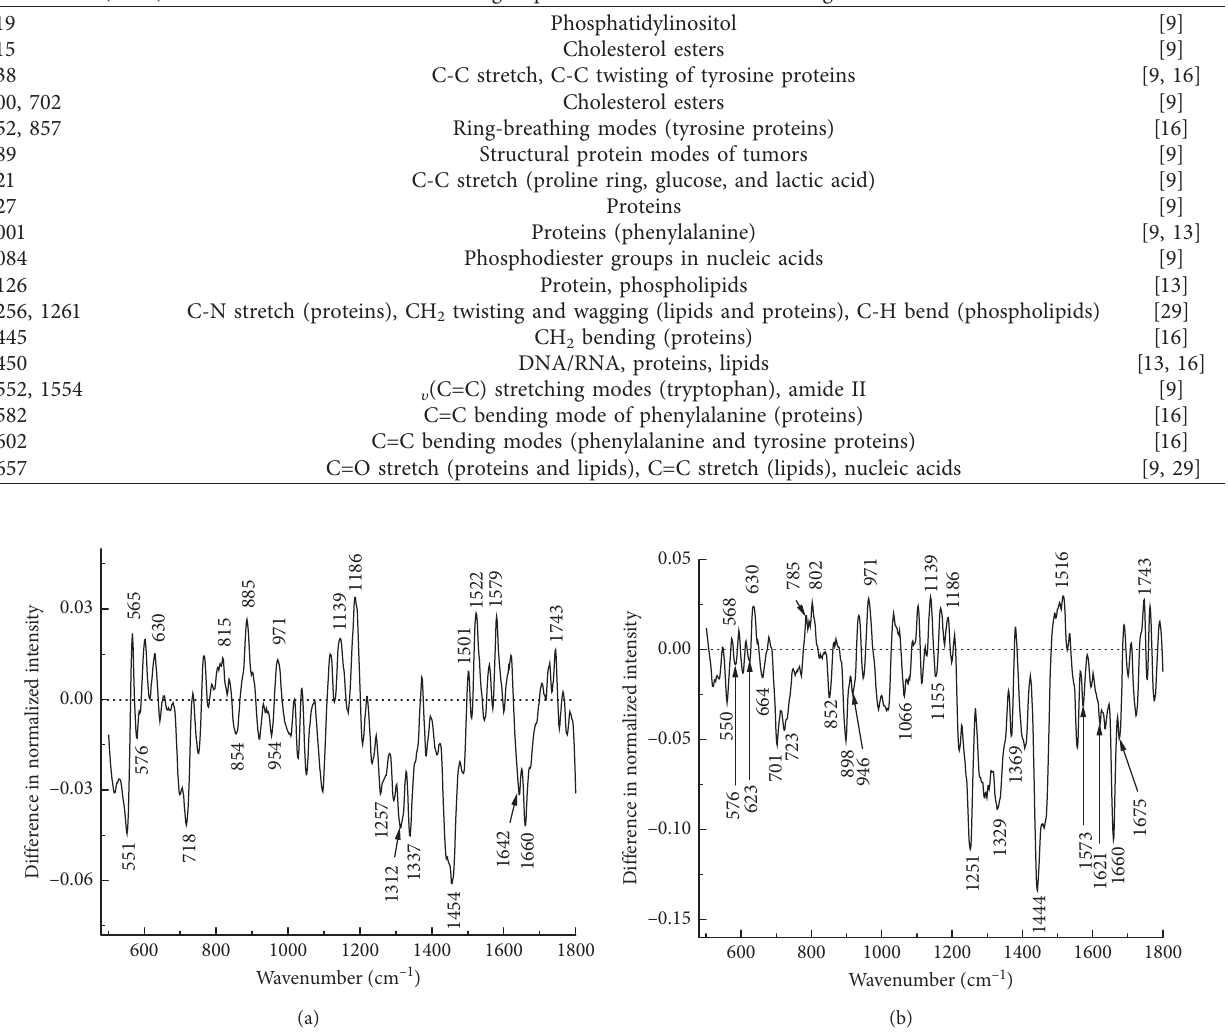
Table 1: Raman band assignments of PC3 and PNT1a prostatic cells. Raman shift (cm − 1